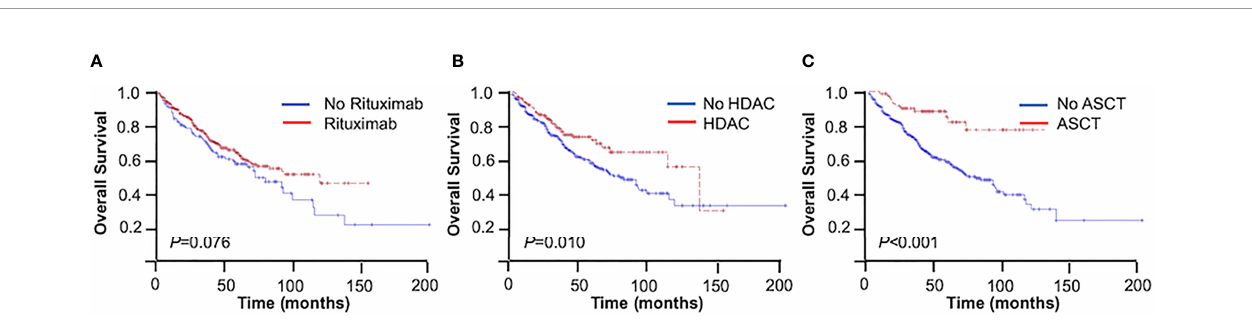
FIGURE 2 | Overall survival (OS) of mantle cell lymphoma (MCL) patients. (A) With or without rituximab. (B) With or without high-dose cytarabine-containing (HDAC) regimen. (C) With or without autologous stem cell transplantation